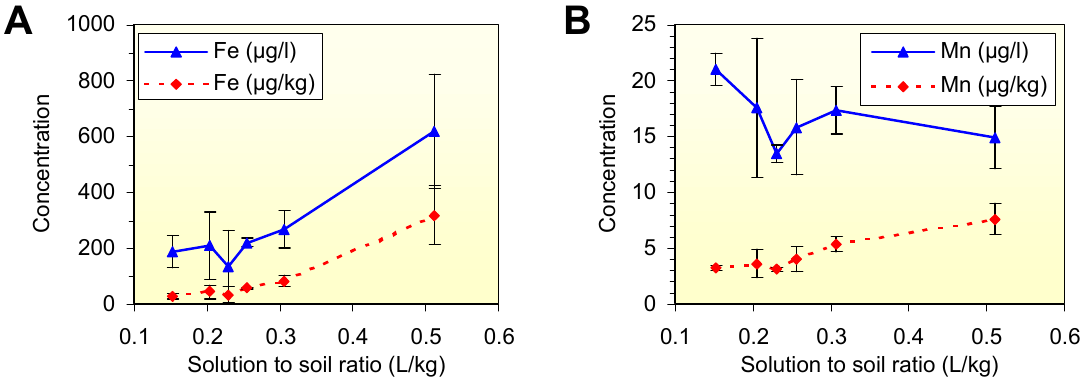
FIGURE 3 . Concentrations in aqueous extracts (solid lines) and extracted amounts (dotted lines) of Fe and Mn as a function of extraction ratio. Error bars denote the standard deviation ( n =